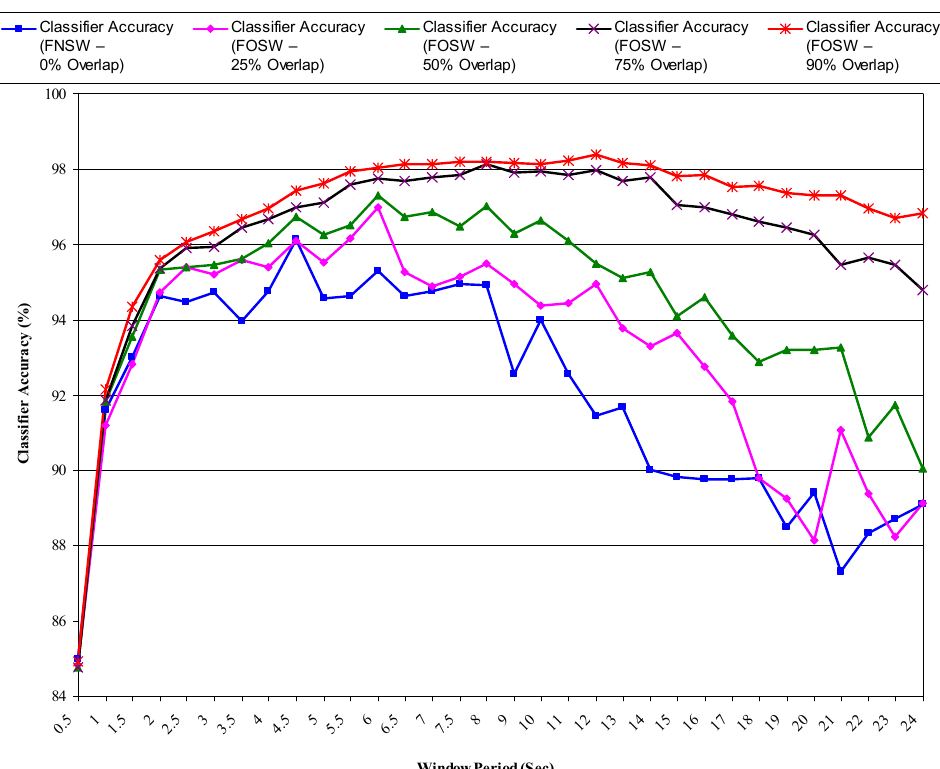
Figure 8. SVM classification accuracies for different window sizes and different window overlaps using SVM